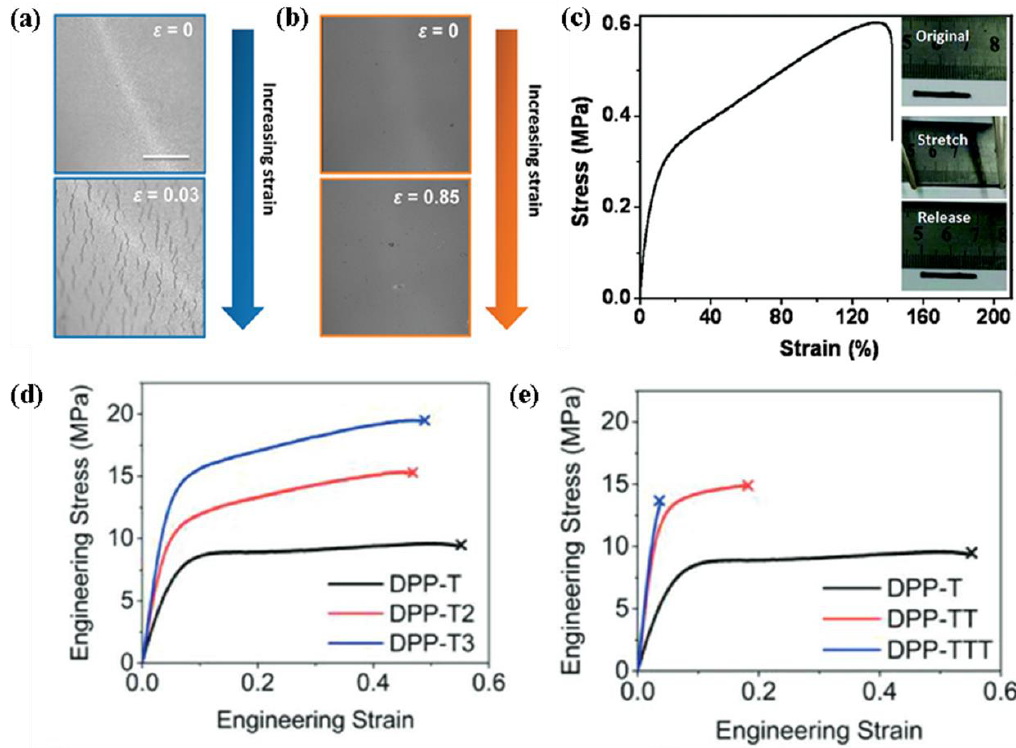
Figure 6. Microscopy images of strained PDPP-TT ( a ) and PDPP-TT–PDMS ( b ), respectively (scale bars denote 50 µ m and ε is the amount of applied strain). ( c ) The strain–stress profile of P3HT–PMA–P3HT triblock copolymer, illustrated by optical photographs at different tensile strains. Stress-strain curves of ( d ) DPP polymer (DPP-T, DPP-T2, and DPP-T3) films with different thiophene unit numbers and ( e ) DPP polymer (DPP-T, DPP-TT, and DPP-TTT) films thickened with thiophene rings in different sizes.